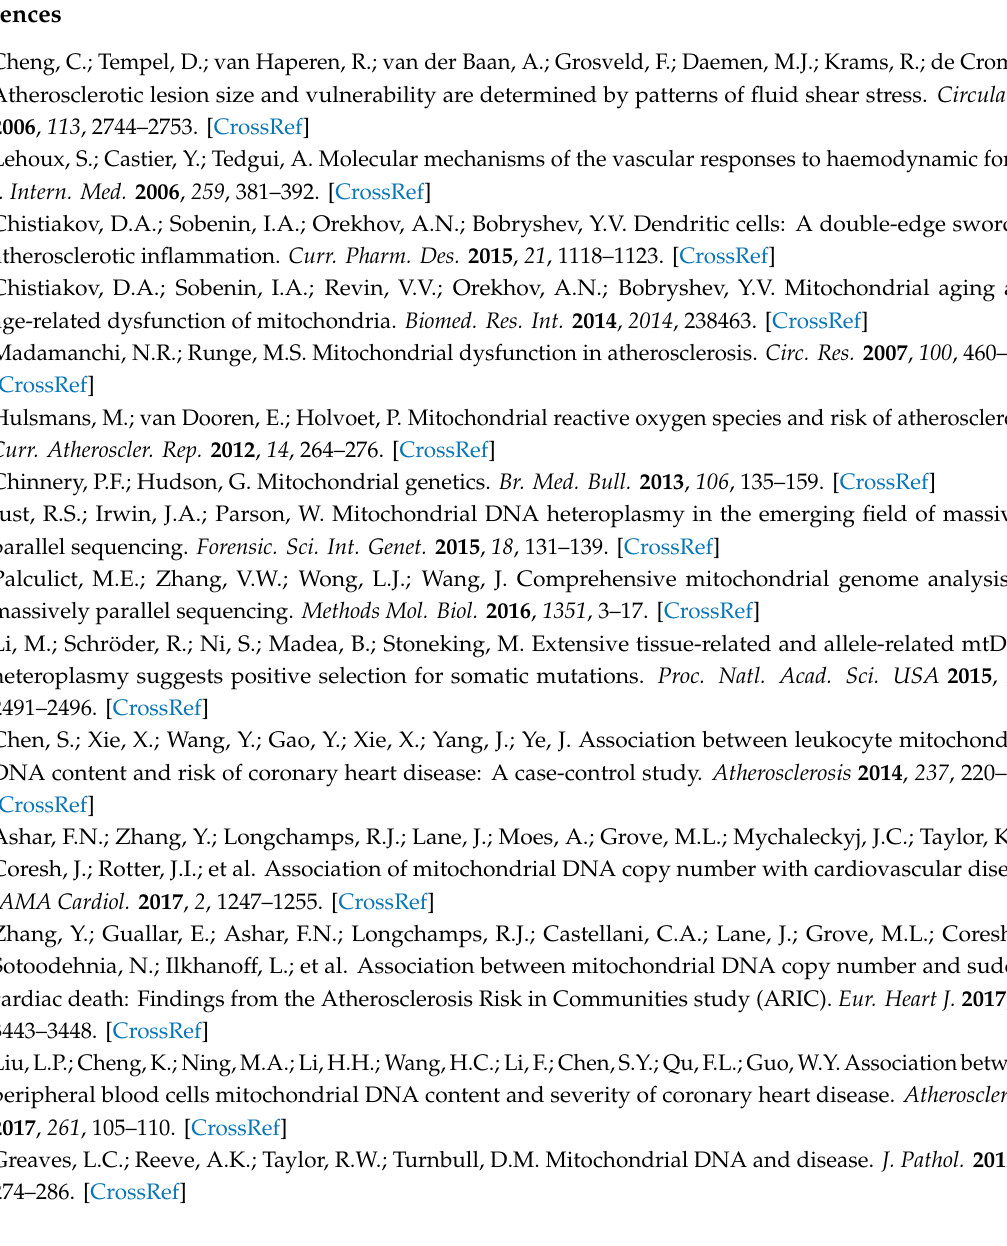
Table S1: MAF values for heteroplasmic mtDNA variants found in the aortic intimal tissue, Table S2: Relative mtCN values in the observed tissue